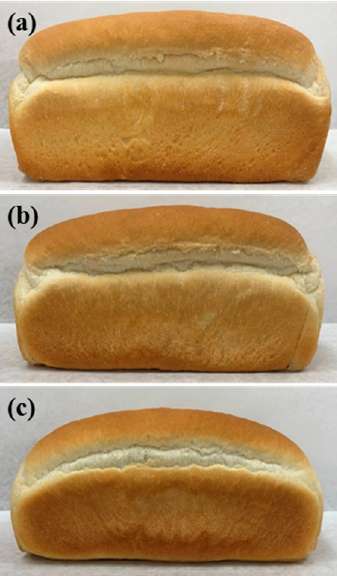
Figure 2. Overall shape and appearance of fresh loaves of amylose-lipid-containing breads. ( a ) Control bread; ( b ) ALC 50% bread was prepared with 50% of the shortening replaced with ALC; ( c ) ALC 100% bread was prepared with 100% of the shortening replaced with ALC.